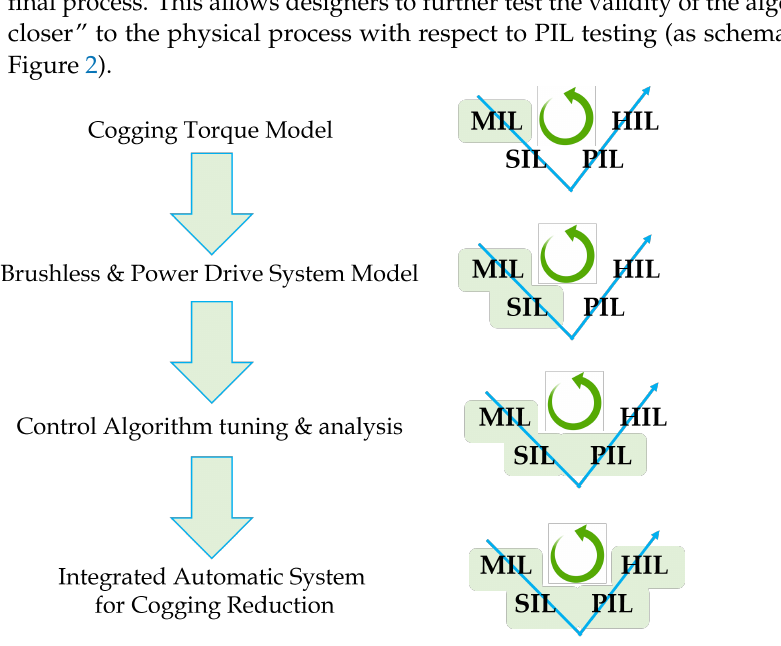
Figure 2. MBD workflow in the specific case of design of control algorithms to reduce the cog- ging